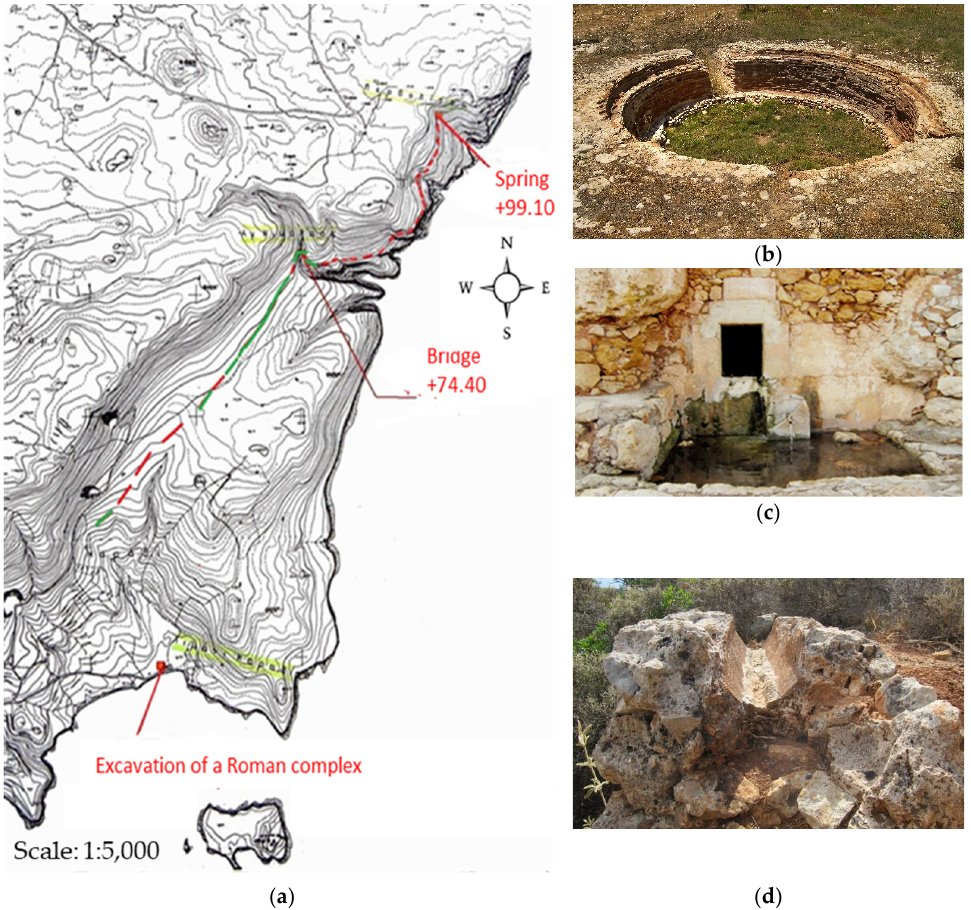
Figure 11. Minoa aqueduct: ( a ) The aqueduct on background scale 1:5000, preserved part in green (provided by Y. Christodoulakos on background of the Hellenic Military Geographical Service maps [38] ); ( b ) cistern at Marathi (photo taken by A. N. Angelakis); ( c ) source at Pervolitsa; and ( d ) cross section of the aqueduct (photos (c) and (d) taken by Y. Christodoulakos. Three wall sections are visible at St. Nikolas, south of Pervolitsa, 1.8 km away